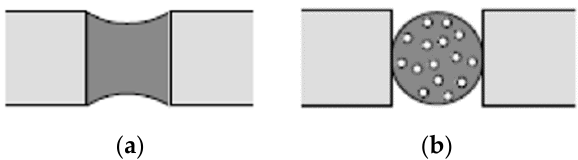
Figure 8. Conventional solution components: ( a ) Sealing compound (caulking); ( b ) Porous gasket (foam backing rod) [32].